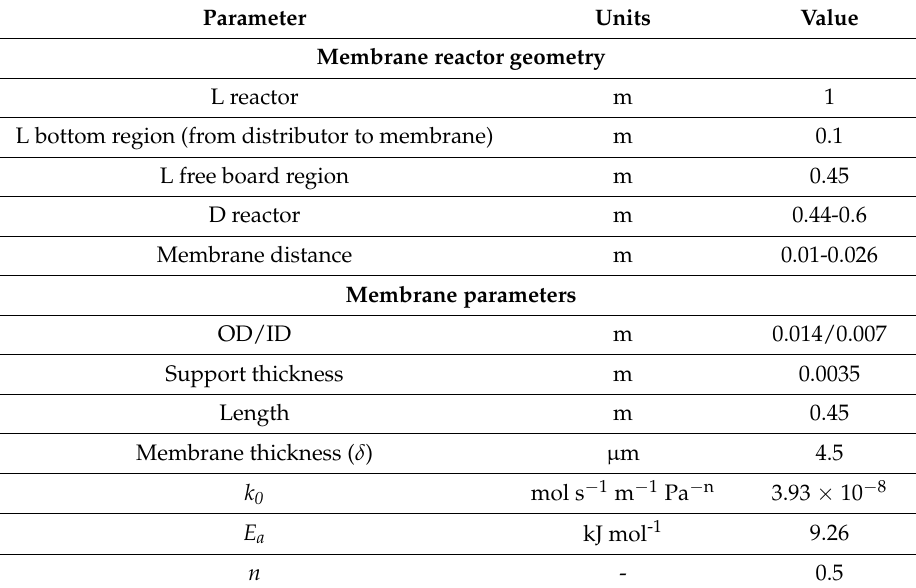
Table A1. Membrane reactor features.